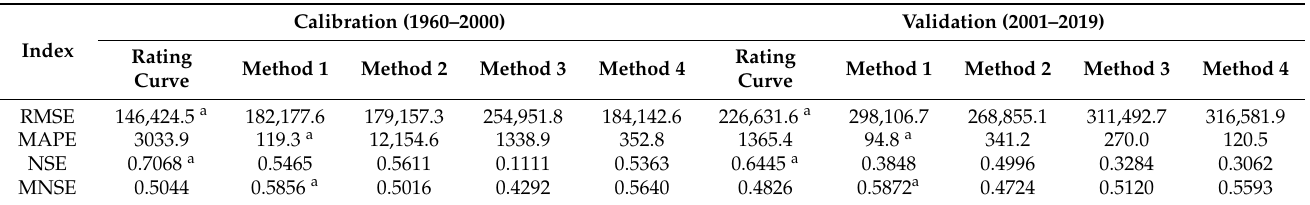
Figure 4. Infilled suspended sediment loads of various methods associated with the recorded data for the period of 1960 − 2019. Table 4. The results of RMSE, MAPE, NSE, and MNSE for various infilling methods for calibration (1960 − 2000) and val- idation (2001 − 2019).